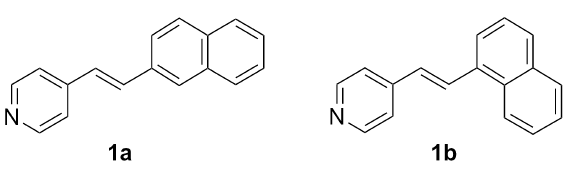
Figure 1. Substrates for photodimerization.